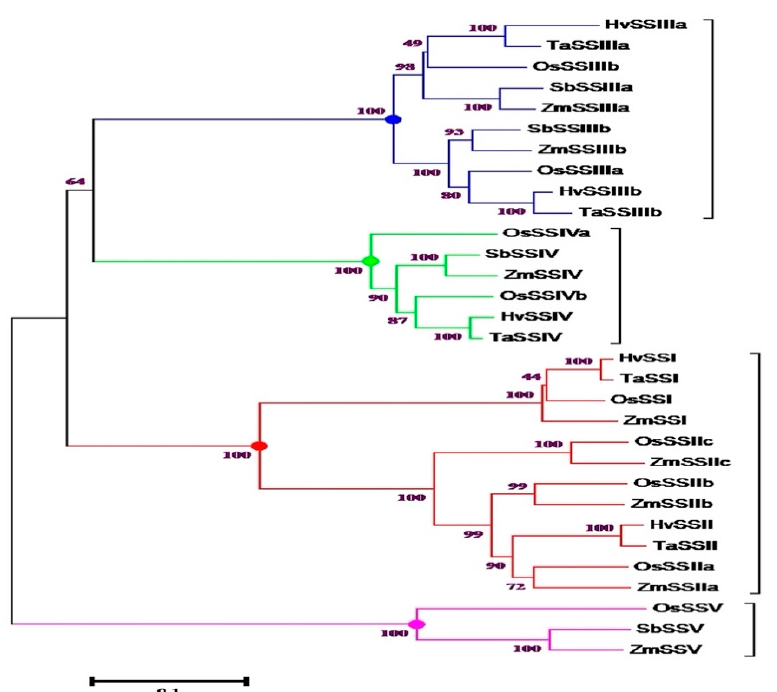
Figure 2. Phylogenetic tree showing the relationship between starch synthase enzymes (SSs) in different cereal crops. The tree was designed by the neighbor-joining method. The bootstrap scores higher than 40 are shown here. Each node is labeled with the prefix of the respective species. The protein accessions numbers are given in Table S1. HvSSI, II, III, IV: Hordeum vulgare starch synthase I, II, III, IV; TaSSI, II, III, IV: Triticum aestivum starch synthase I, II, III, IV; OsSSI, II, III, IV, V: Oryza sativa starch synthase I, II, III, IV, V; ZmSSI, II, III, IV, V: Zea mays Starch synthase I, II, III, IV, V.